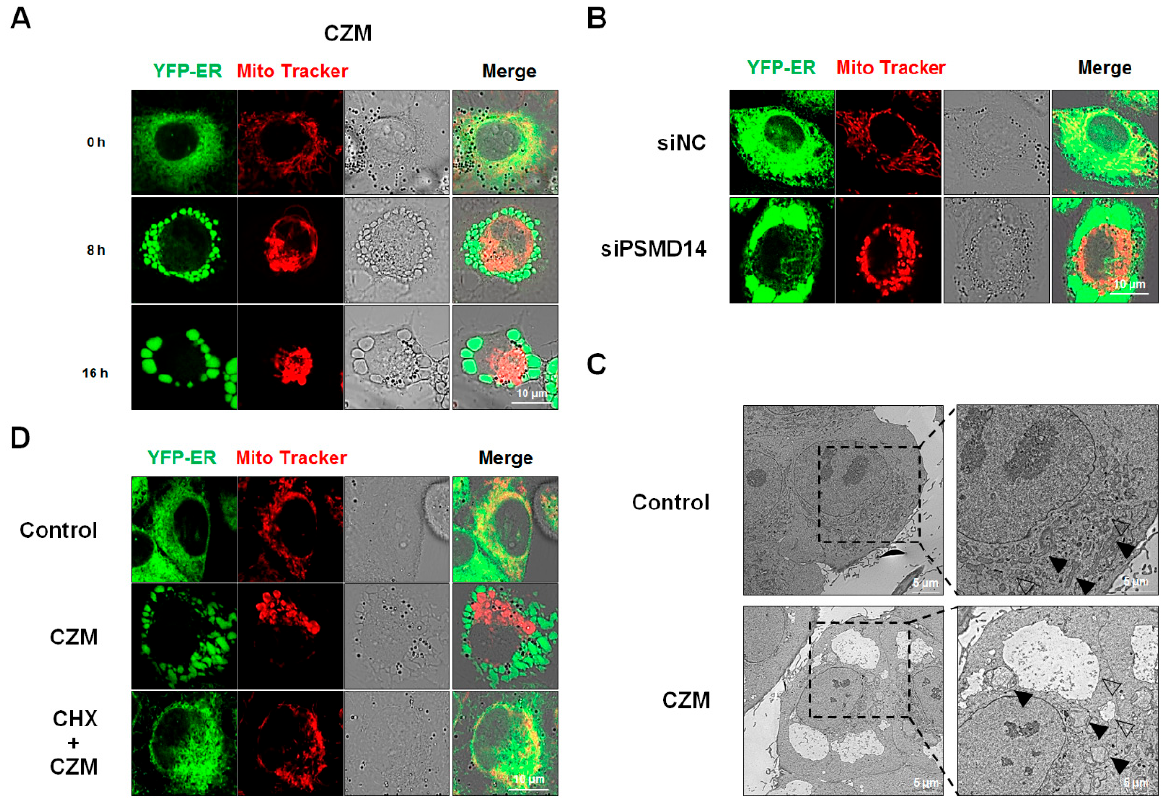
Figure 2. Targeting PSMD14 induces paraptosis in MDA-MB 435S cells. ( A , B ) YFP-ER cells were treated with 5 µ M CZM for the indicated time durations ( A ) or transfected with siRNA against PSMD14 for 36 h ( B ) and stained with MitoTracker-Red. Cells were observed under the confocal microscope. Bars, 10 µ m. ( C ) MDA-MB 435S cells treated with 5 µ M CZM for 12 h were subjected to electron microscopy. Bars, 5 μ m. ( D ) YFP-ER cells pretreated with or without 1 μ M CHX were fur- ther treated with 5 μ M CZM for 12 h, stained with MitoTracker-Red, and observed by confocal mi- croscopy. Bars, 10 μ m.